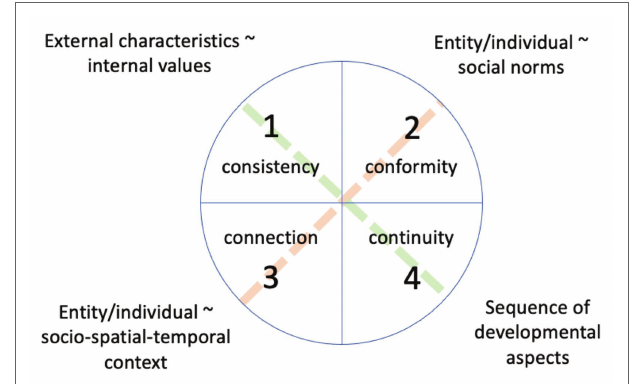
FIGURE 1 | The 4-C model of authenticity with personal axis (green diagonal) and social axis (red diagonal) displayed in juxtaposition. The personal axis refers to the congruence of internal values and external characteristics (C1) and the congruence of the individual’s personal development with what is expected to be typical in their community (C4). The social axis refers to the congruence of the individual and the social norms of their community (C2) and the congruence of the individual and their social position